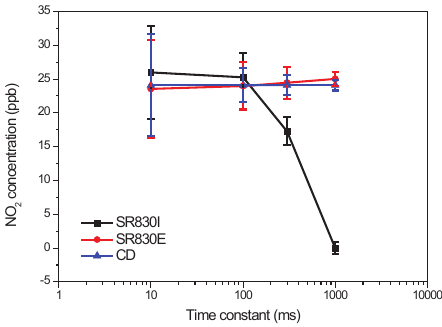
Figure 9. Performance comparisons of the estimated NO 2 concentration obtained with a SR830 lock-in amplifier and the proposed CD approach. The error bars are the standard deviation of the concentration estimates.